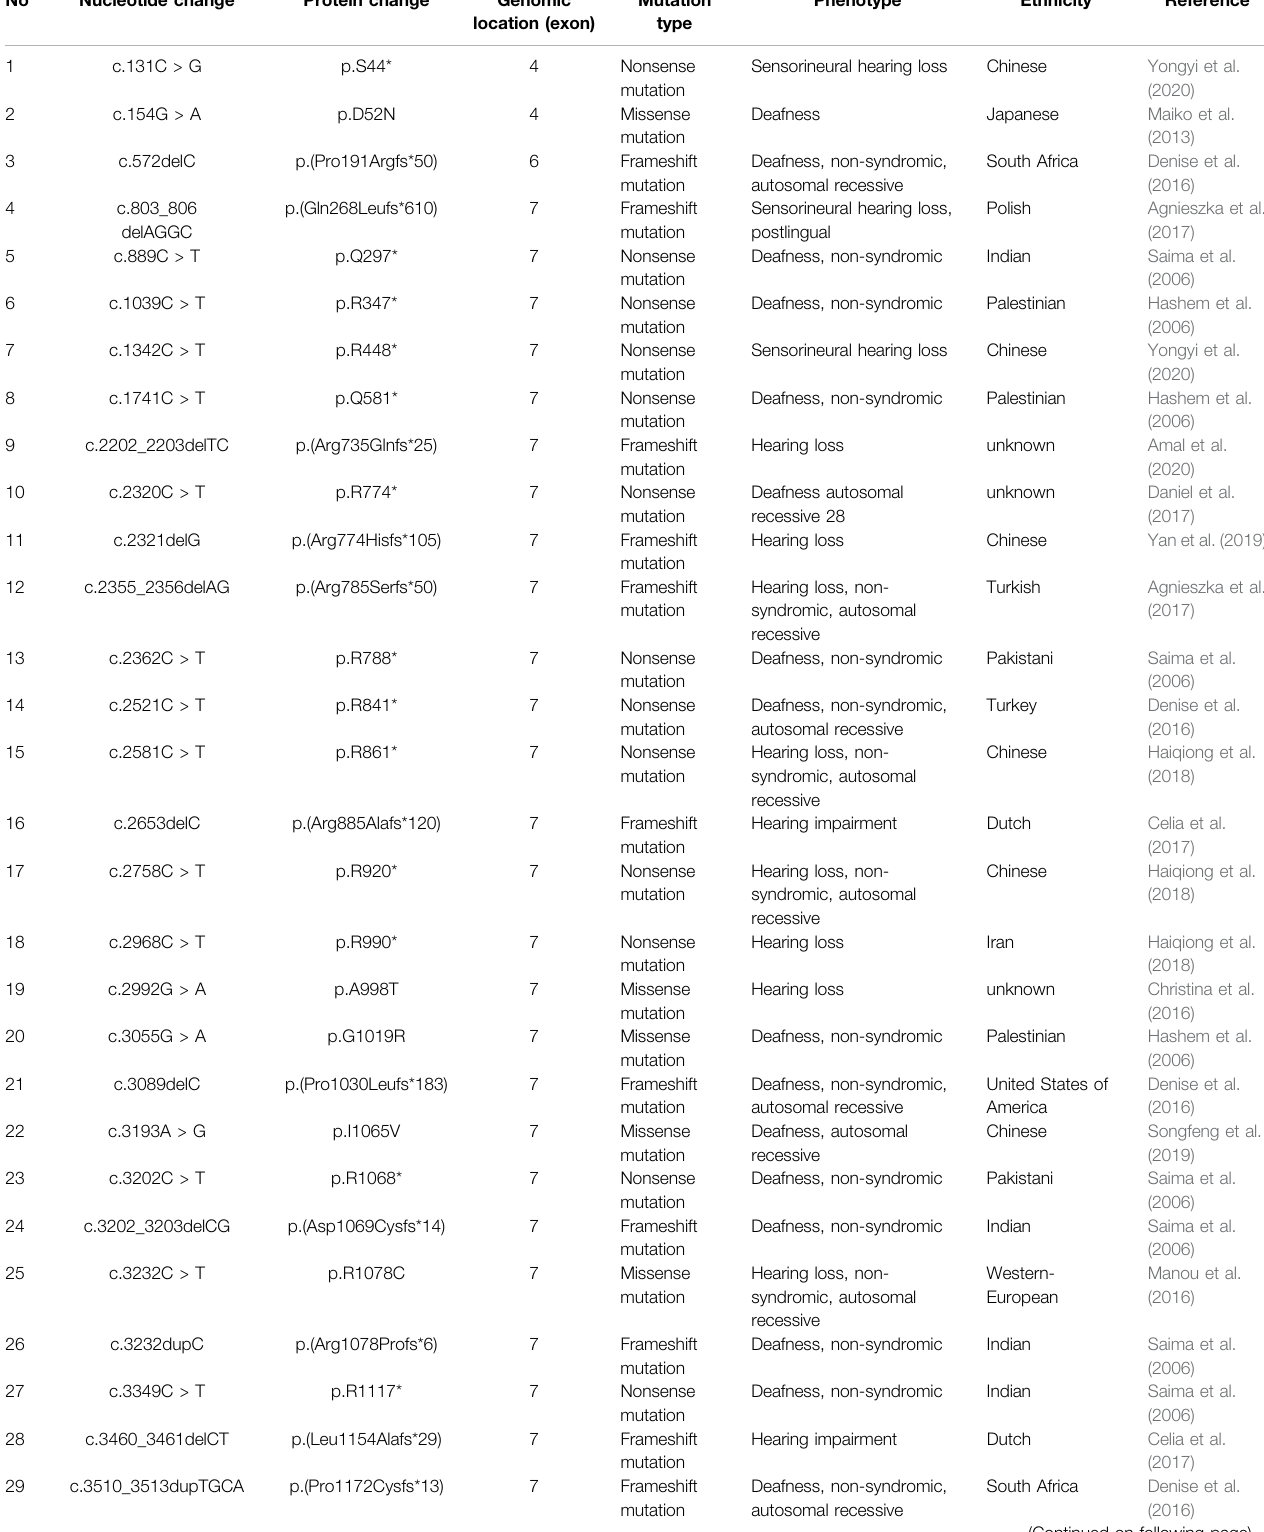
TABLE 1 | Disease causing mutations in the TRIOBP gene (NM_001039141.2) according to The Human Gene Mutation database